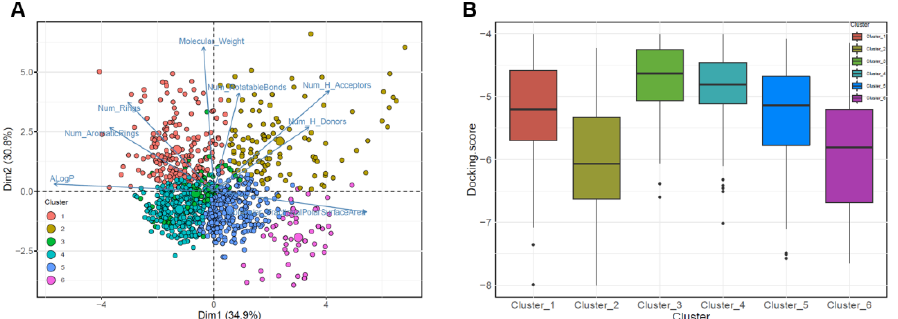
Figure 4. Principal component analysis clustering plot of the chemical space of prepared datasets. The loading plot vectors are represented by arrows for each physicochemical property. ( A ) The red, mustard, green, cyan, blue, and magenta dots correspond to clusters 1, 2, 3, 4, 5, and 6, respectively. Data points are color-coded by clusters of molecules. ( B ) Boxplots for SP Glide score distributions of prepared dataset for each cluster (Clusters 1–6).